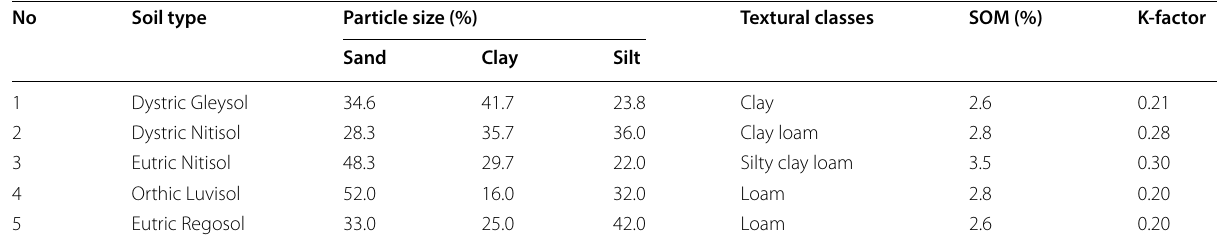
Table 2 K-factor determined from soil organic matter and texture analysis data of Gelda catchment using Stone and Hilborn (2012)